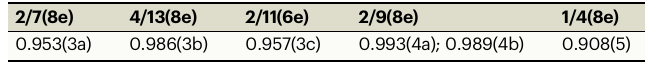
^ V LLL ∣ ψ σ g i with respect to C are